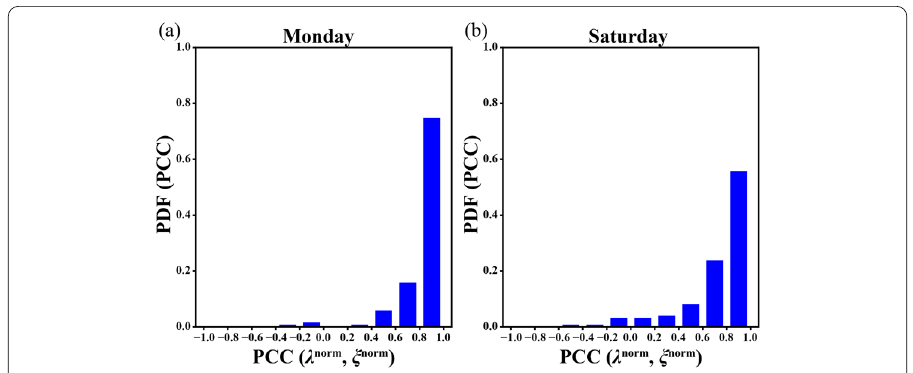
Figure 10 PCCs between coupling strength and average trip distance weighted fraction of travelers from ordinary zones